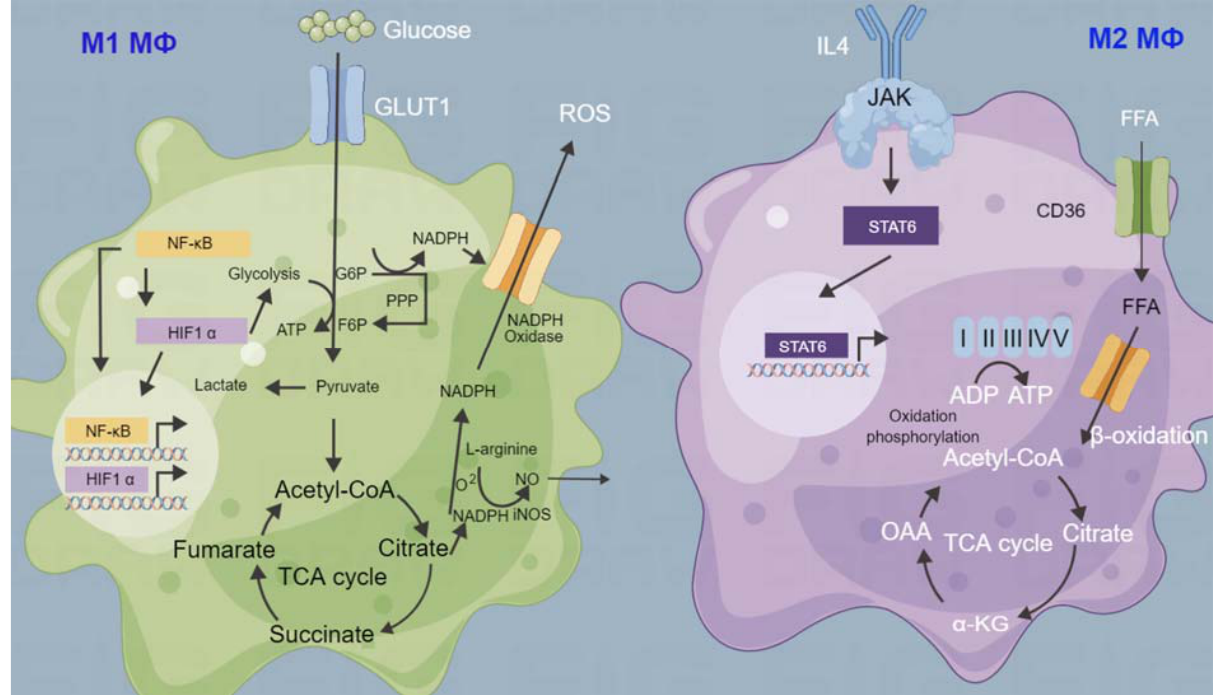
Figure 2. Metabolic difference between tumor ‐ associated macrophage (TAM) M1 and M2 type. Metabolites of cancer cells and stromal cells in the tumor microenvironment (TME) lead to metabolic reprogramming of TAMs and change the composition and function of TAMs. M1 ‐ type TAMs have a high level of aerobic glycolytic activity and can produce oxygen species (ROS) to kill cancer cells. M2 ‐ type TAMs rely on high levels of oxidative phosphorylation (OXPHOS) to produce cytokines to promote the proliferation of cancer cells. G6P: glucose ‐ 6 ‐ phosphate; F6P: fructose ‐ 6 ‐ phosphate;